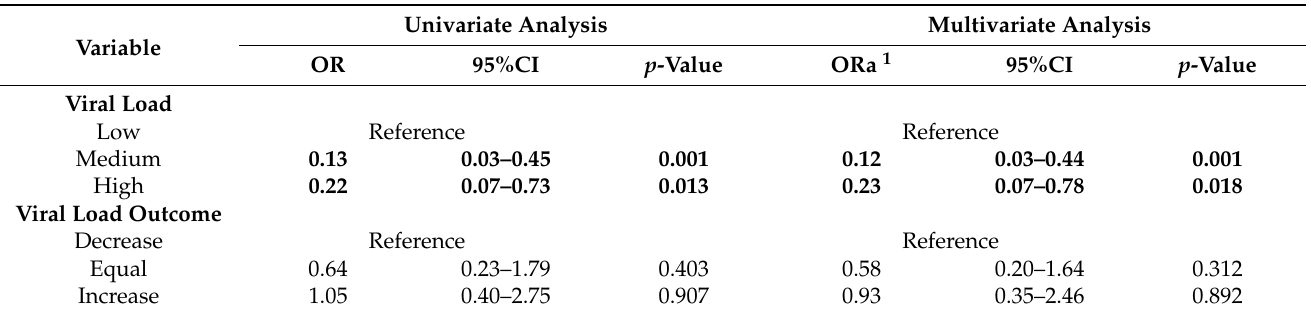
Figure 5. Lactobacillus composition of cervical samples. ( A ) Bar plots showing the main bacterial species by viral load, considering all follow-up time points (first and second), and categorizing women according to their VL despite their follow-up time point. ( B ) Bar plots showing the main bacterial species by viral load outcome. For this figure, we only considered the VL outcome at 12 months. Table 1. Results of the logistic regression to determine the variables associated with the Lactobacillus species depletion (<60%) according to the evaluated